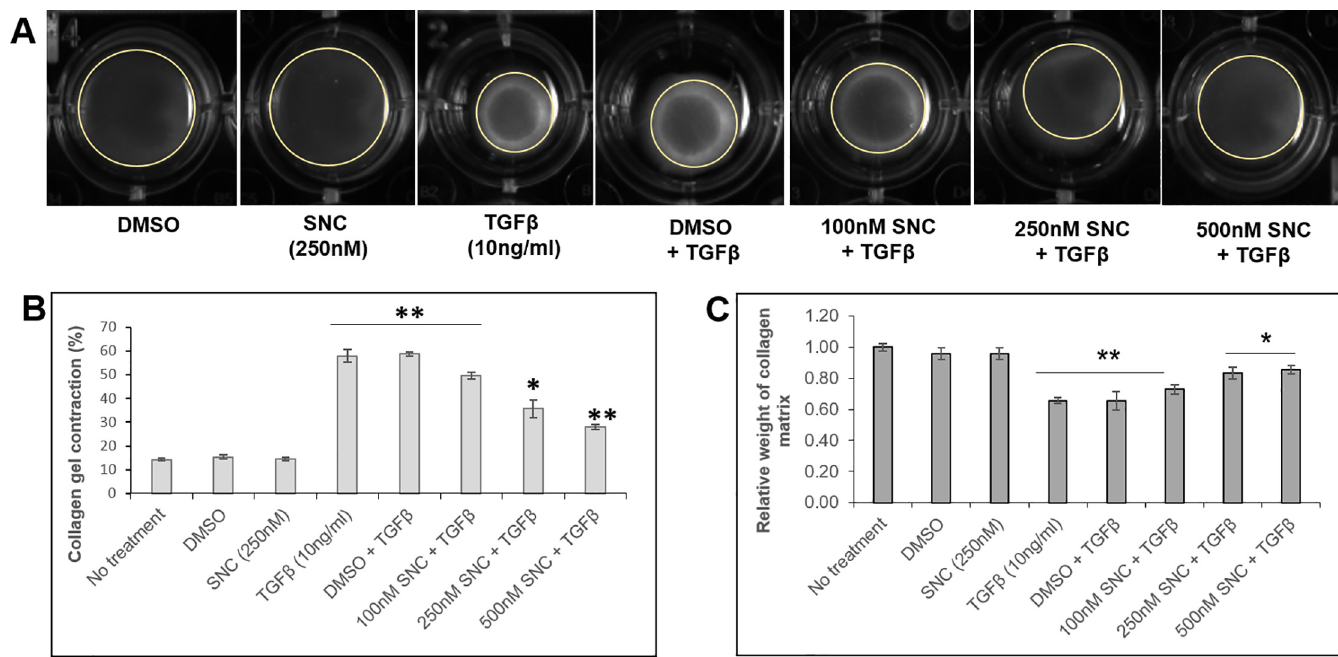
Fig 4. Salinomycin (SNC) inhibits TGF β -induced contraction of a collagen matrix in ARPE-19 cells. A) ARPE-19 cells (2–3 x 10 5 total cells) were embedded in a collagen matrix and incubated in media with the different treatments shown. After 72h of treatment, SNC+TGF β , but not DMSO+TGF β , inhibited the contraction of a collagen matrix in a dose-dependent manner. A representative gel area for each treatment is outlined with a yellow circle. Quantification of the areas measured (B) and weight of the collagen gel at 72 h (C) confirm that SNC inhibits contraction. Areas were quantified using ImageJ. � p < 0.05; �� p < 0.01 (ANOVA with Tukey post-hoc analysis) when compared to untreated cells. All treatments were performed in triplicate and at different cell passages.